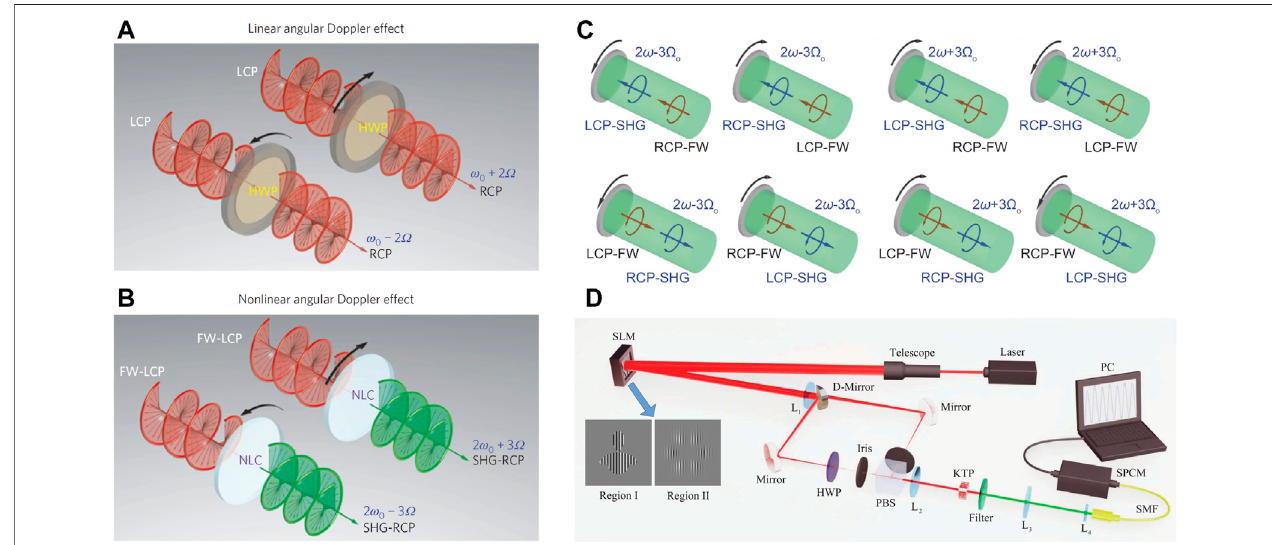
FIGURE 5 | RDE in nonlinear optics. RDE in (A) linear and (B) nonlinear optics. The second harmonic generation signal experiences a Doppler shift of three times [24]. (C) The evolution of RDE of second harmonic generation from a quartz coated with silver mirror [71]. (D) RDE detection by frequency up-conversion [72].